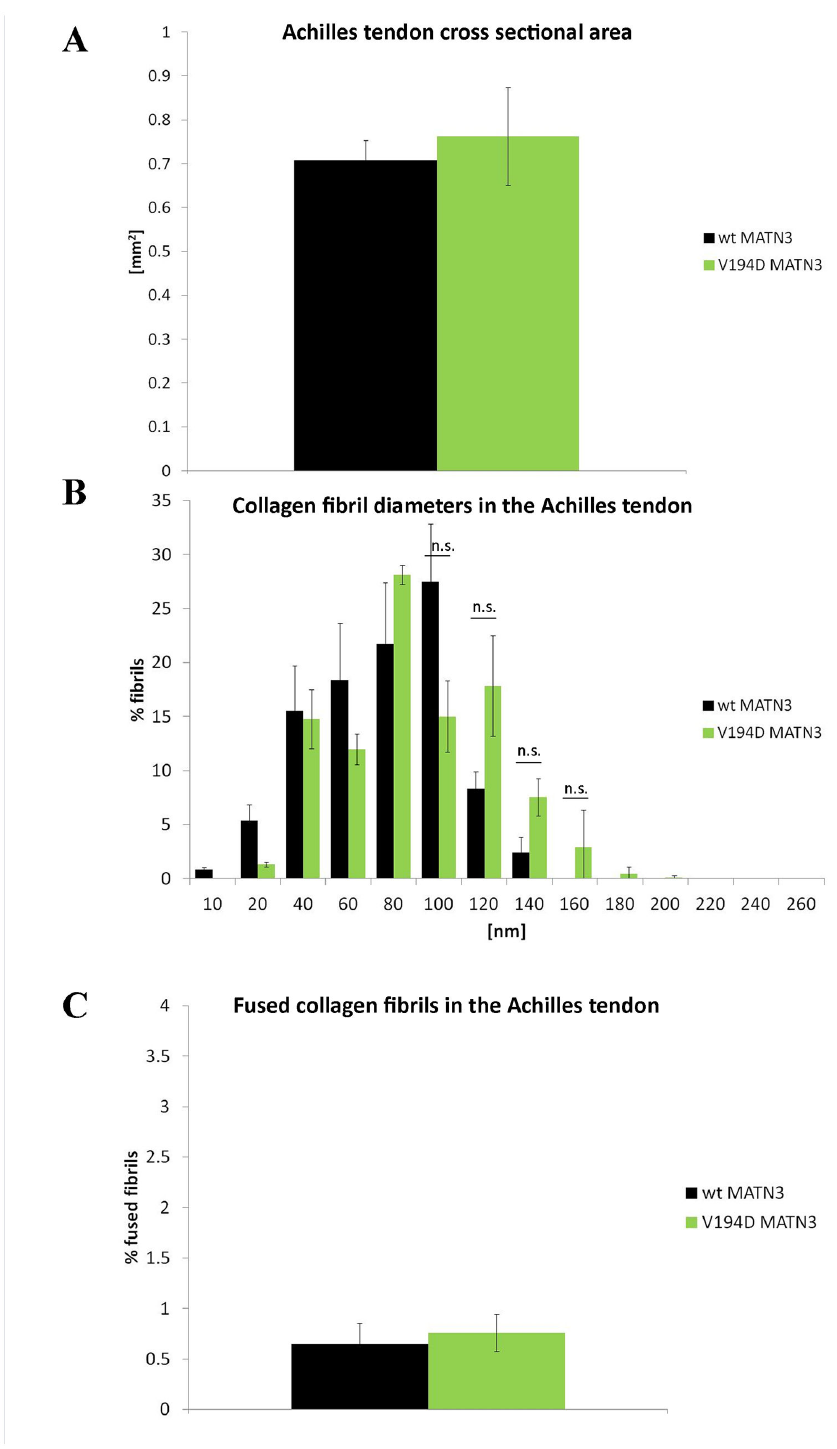
Figure 5. Analysis of the ultrastructure of the mutant MATN3 Achilles tendon at 3 weeks. A ) Measurement of the cross sectional area of wild type and mutant tendons. V194D MATN3 tendons were not thinner than wild type controls at 3 weeks, n>10. B ) MATN3 mutant tendons contained similar amounts of both thinner and thicker collagen fibers than the wild type controls, n=3. C ) MATN3 mutant tendons contained similar amounts of fused/branching collagen fibers when compared to the wild type tissues at 3 weeks of age, n=3. Error bars; SEM (standard error of the mean). Key: * P<0.05, ** P<0.01, *** P<0.001. doi: 10.1371/journal.pone.0082412.g005 PLOS ONE |